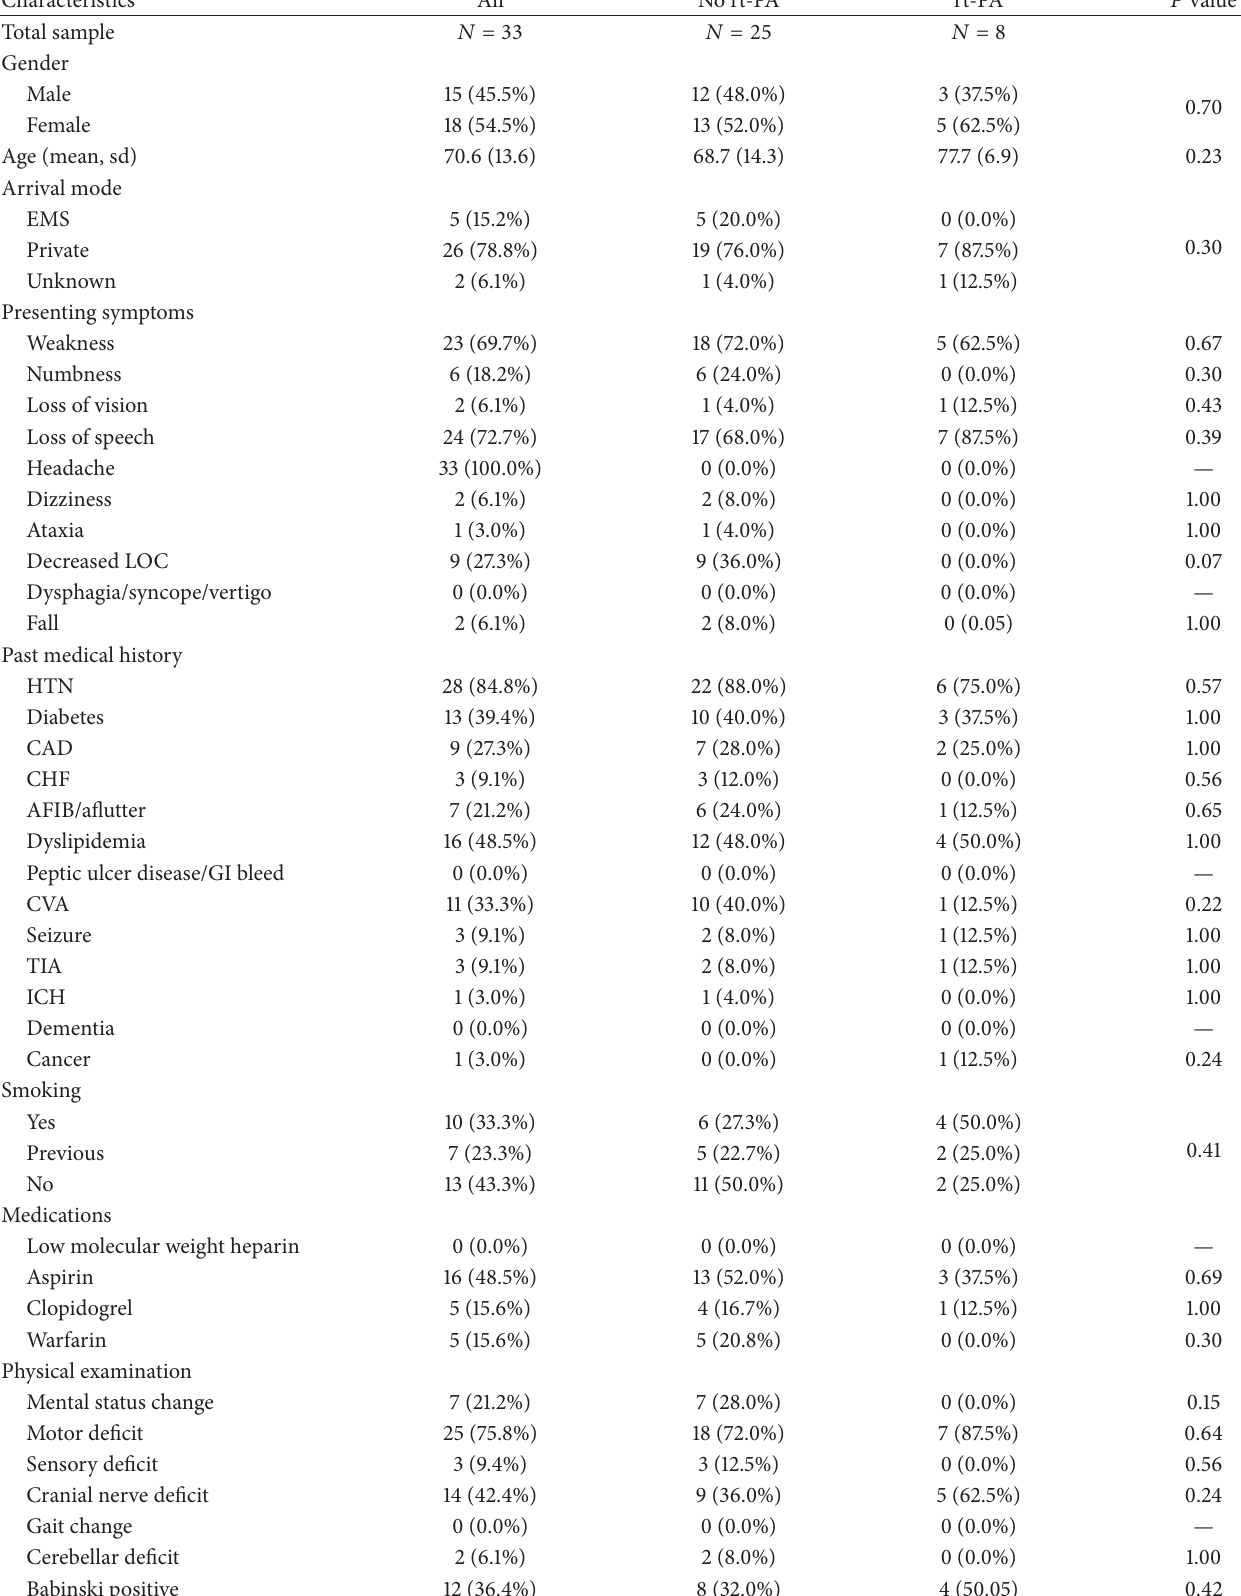
Table 2: Characteristics of patients presenting within 4.5 hours from symptom onset by group (rt-PA versus no rt-PA).